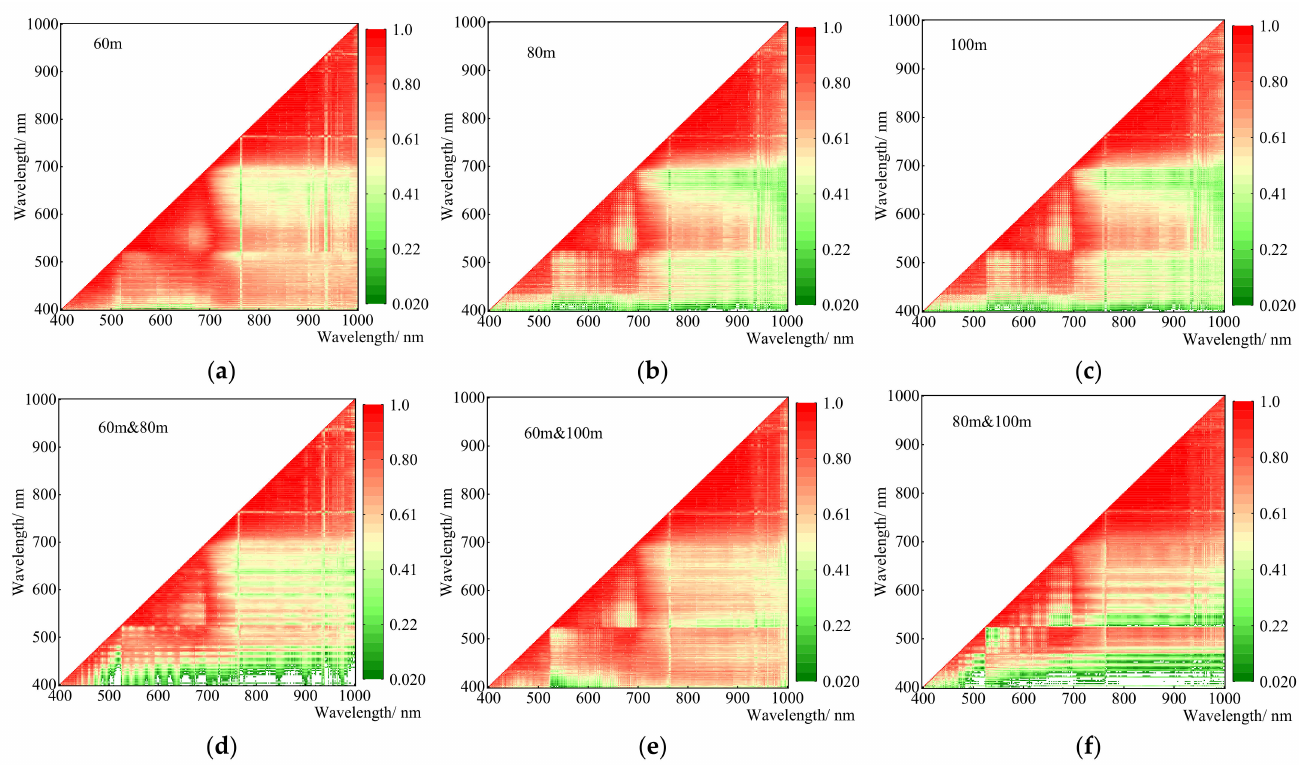
Figure 5. Correlation coefficient between spectral reflectance (SR) and SR at the same heights ( a – c ) and correlation coefficient between SR and SR at different heights ( d – f